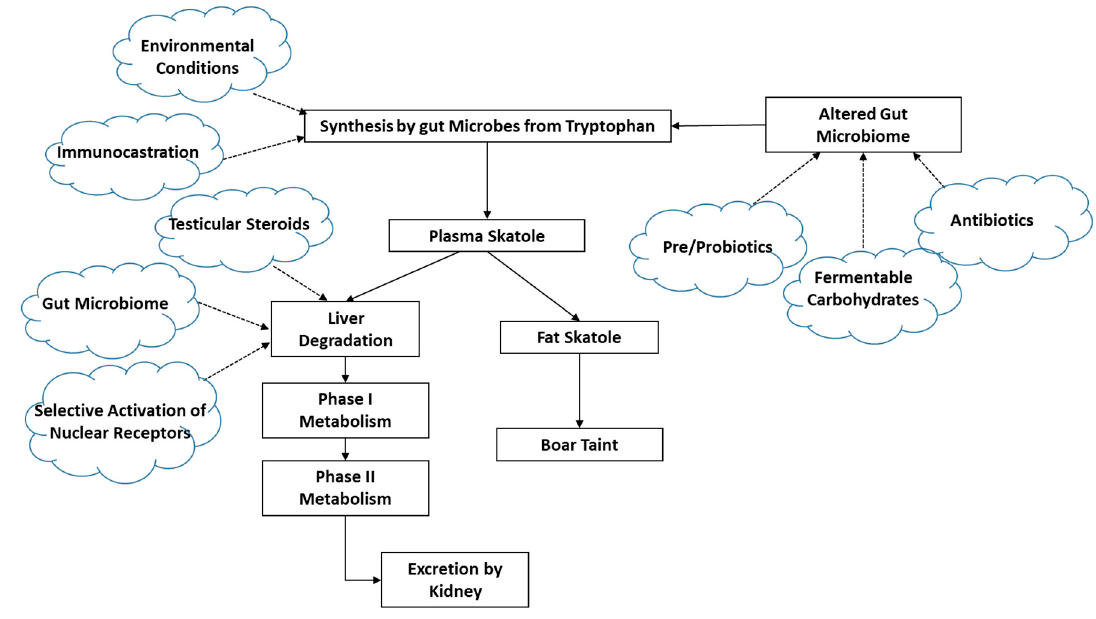
Figure 4. Flow chart of skatole synthesis and metabolism and factors affecting boar taint.